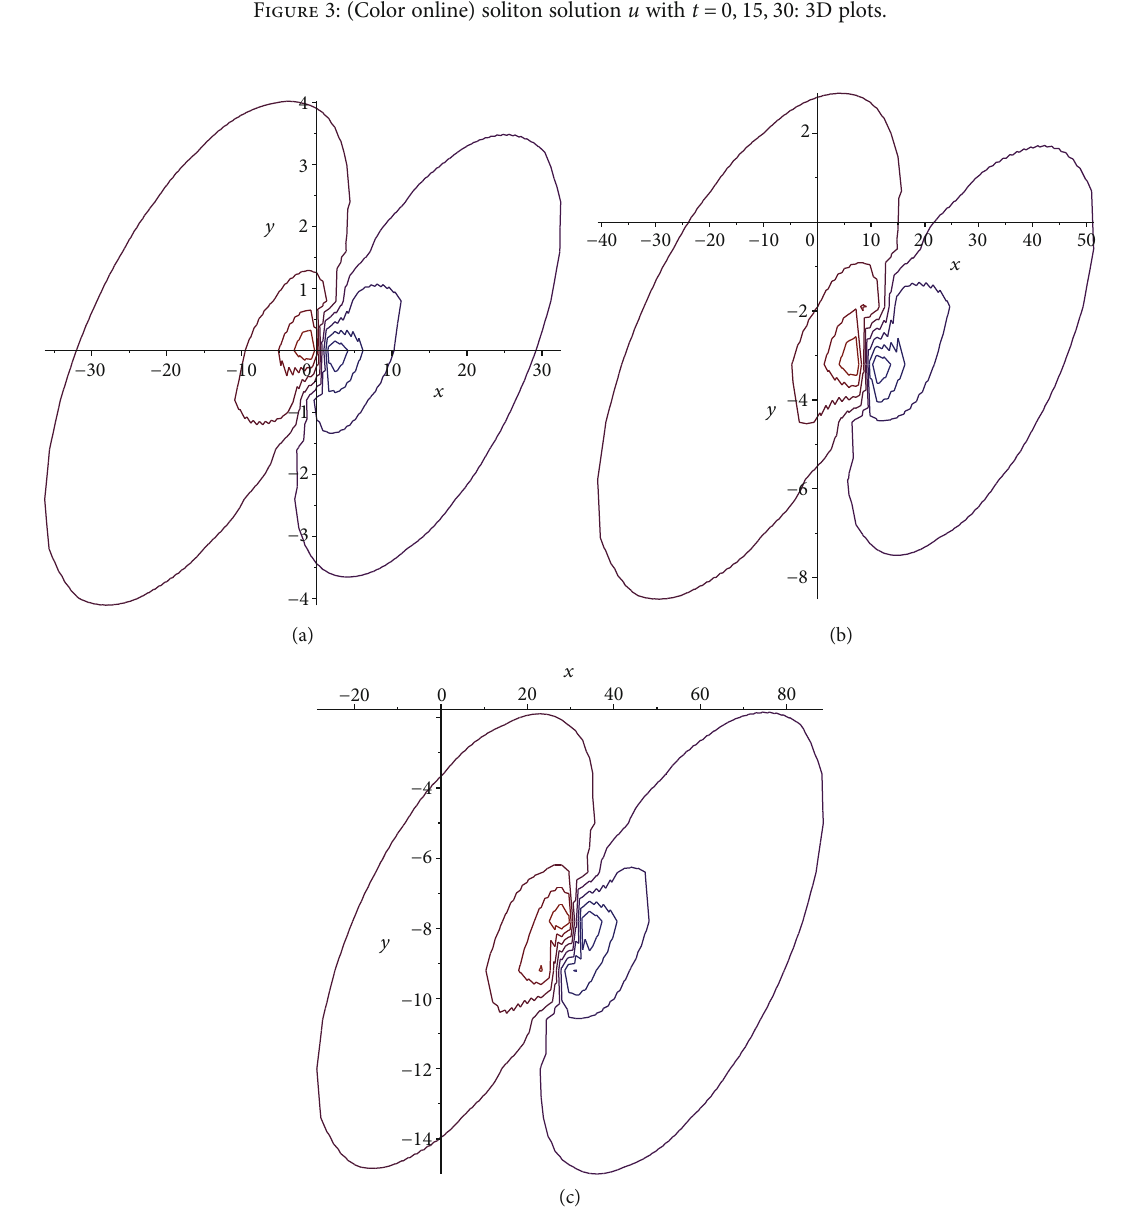
Figure 4: (Color online) soliton solution u with t = 0, 10, 30 : contour plots.